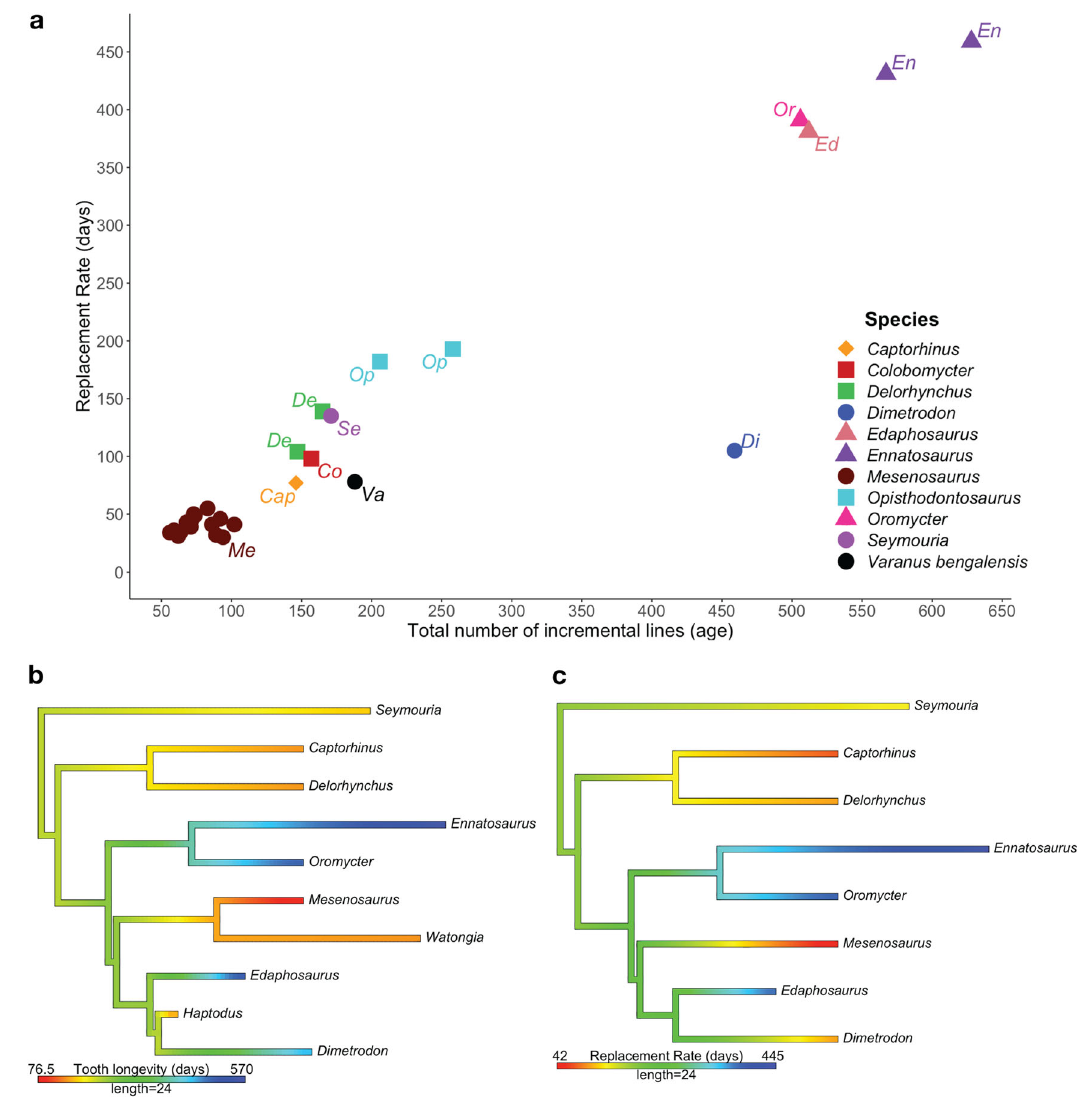
Fig.5|Ratesoftoothreplacementandageacrossarangeoftaxa.a Relationship betweenthetotalnumberofincrementallinesofvonEbner(age)forthefunctional tooth and the tooth families replacement rate or period (days). The symbols indi- cate the type of feeding behaviour, with circles representing carnivory, triangles representing herbivory, square representing insectivory, and diamond represent- ingomnivory. b Phylogenetictreeofalltaxa( n =11)usedintheanalyses,displaying